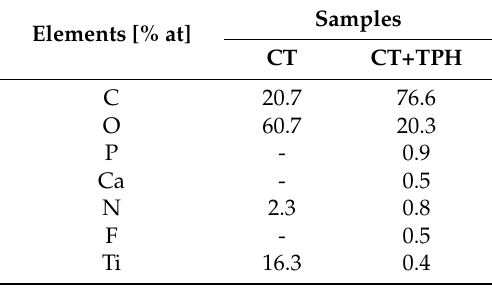
Table 1. The atomic percentages of the elements detected on the surface of samples CT + TPH and